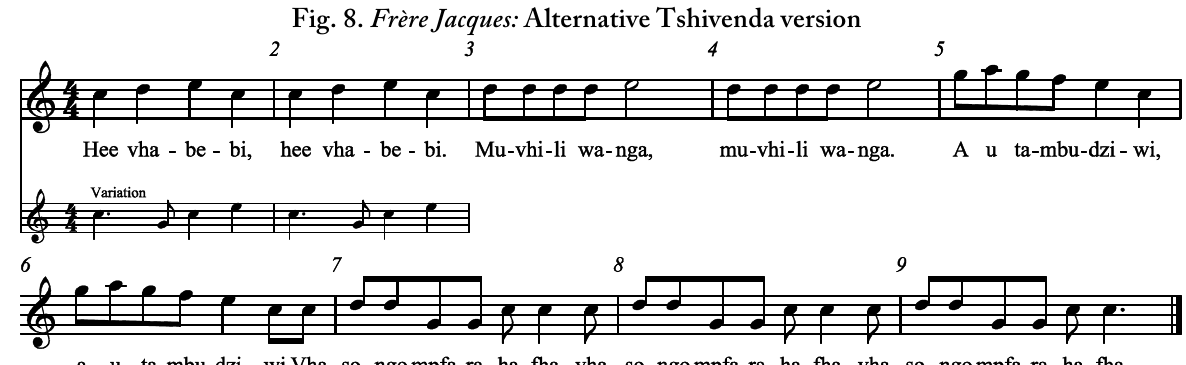
Fig. 8. Frère Jacques: Alternative Tshivenda